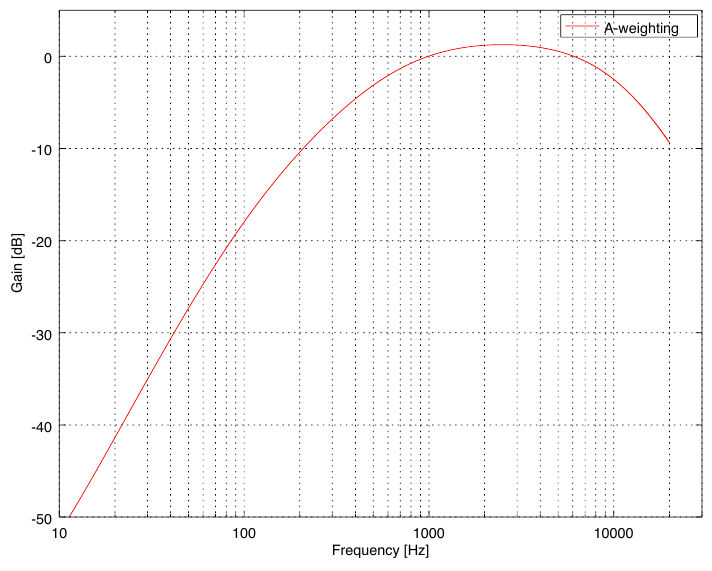
Figure 1. Magnitude response of the A-weighting